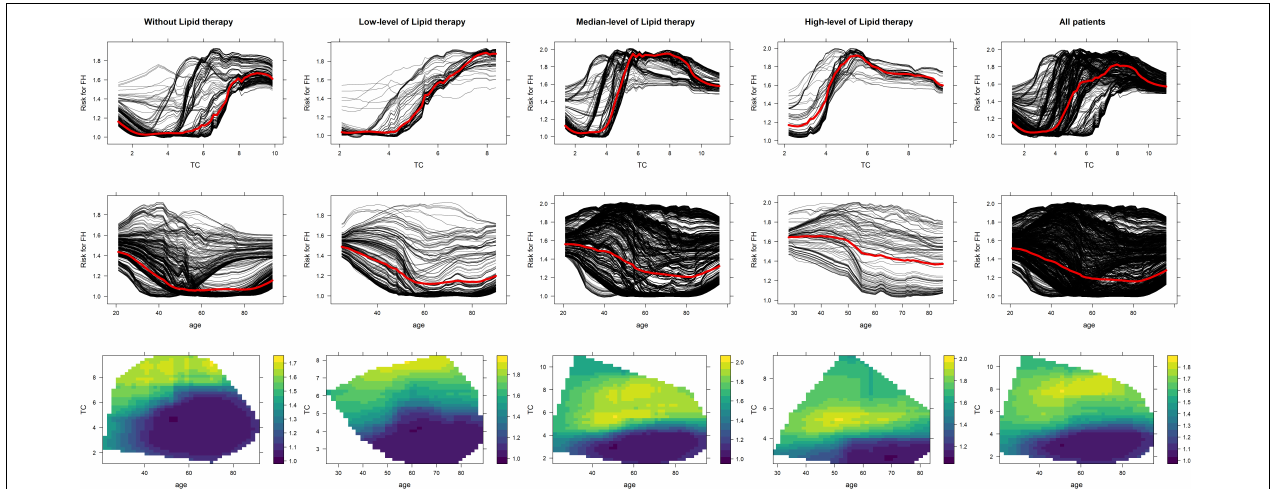
FIGURE 3 | The interpretation among age, LDL-c, and lipid-lowering therapy to FH